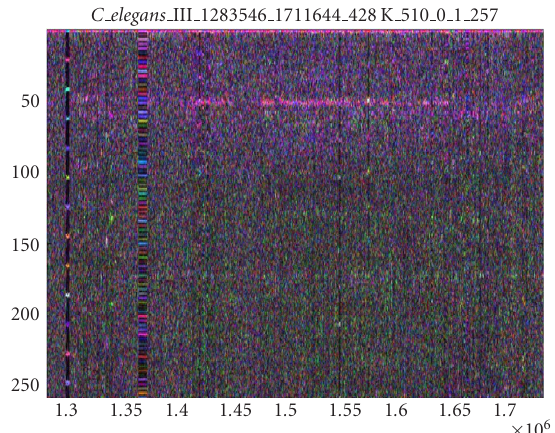
Figure 9: Spectrogram of 189 Kbp section of the right arm of C. ele- gans chromosome III. Note that the periodicity is shown on the ver- tical scale. The arrows point to sections of the spectrogram, show- ing a single instance of the highly dispersed repeat family. Varia- tions of the pattern can be seen throughout the spectrogram. A purple 8.75-base periodicity, as well as a green 3.9-base periodic- ity, identifies this family of strings. The harmonics between 3.9 and 8.75 (the beads of color between 3.9 and 8.75) change color from one repeat to another, indicating that they are di ff erent but related strings. These tandem repeats are non-protein-coding regions. The 10+-base periodicity is antagonistic with the repeat family. This pat- tern is found over 3Mbp of the right arm of the